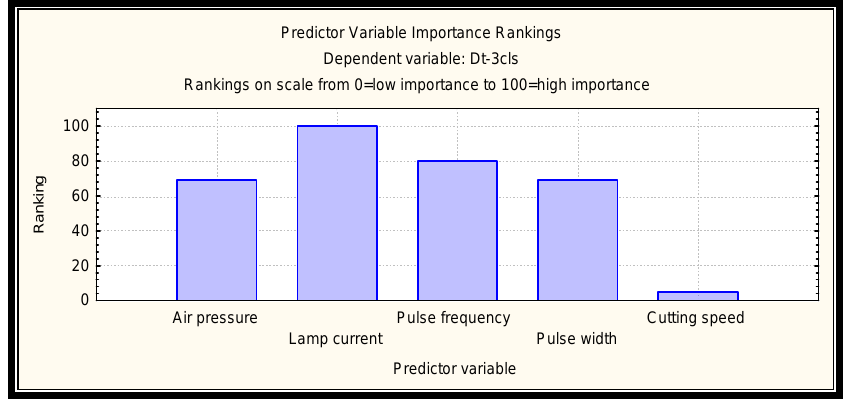
Fig. 12. Predictor variable importance ranking for deviation of taper